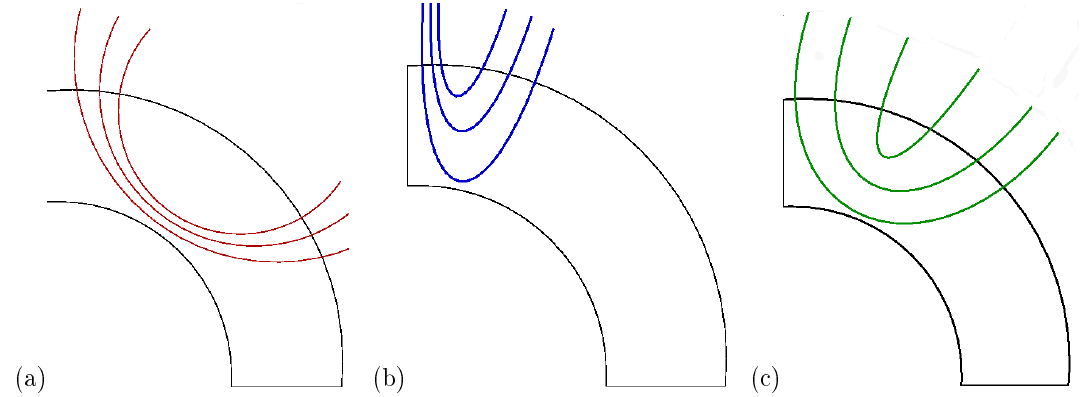
Fig. 1. Depending on the field geometry below the surface, (a) weak radial fields could be associated with strong latitudinal fields or (b) vice versa, or weak radial fields could also be associated with weak latitudinal fields (c)